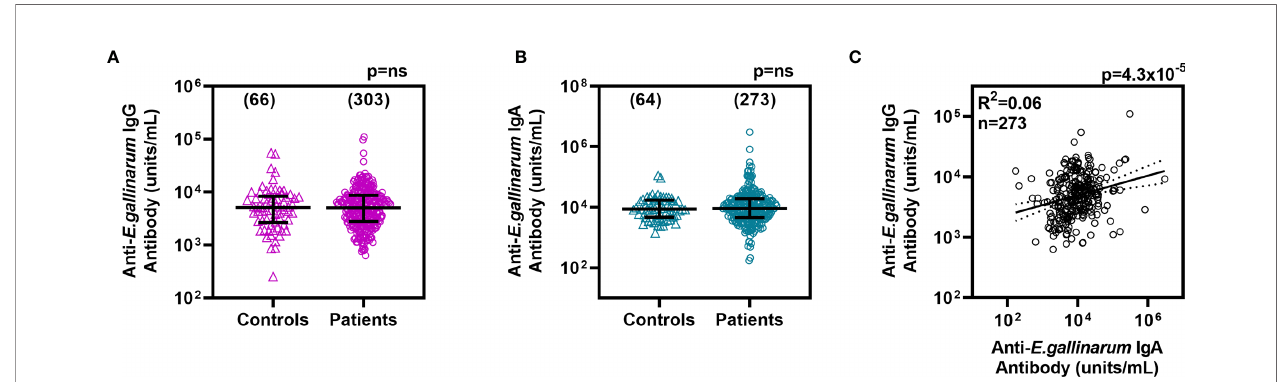
FIGURE 1 | IgG anti- Eg (A) and IgA anti- Eg (B) titers in sera from healthy controls and lupus patients. Antibody titers are plotted as units/mL and the lines show median ± interquartile ranges. Correlation between IgG and IgA anti- Eg titers in lupus patients (C) . Each data point represents one serum sample and the number of samples studied are shown in parentheses. Antibody levels were compared by Mann-Whitney test and the correlation coef fi cient was determined by Pearson ’ s method. ns, not signi fi